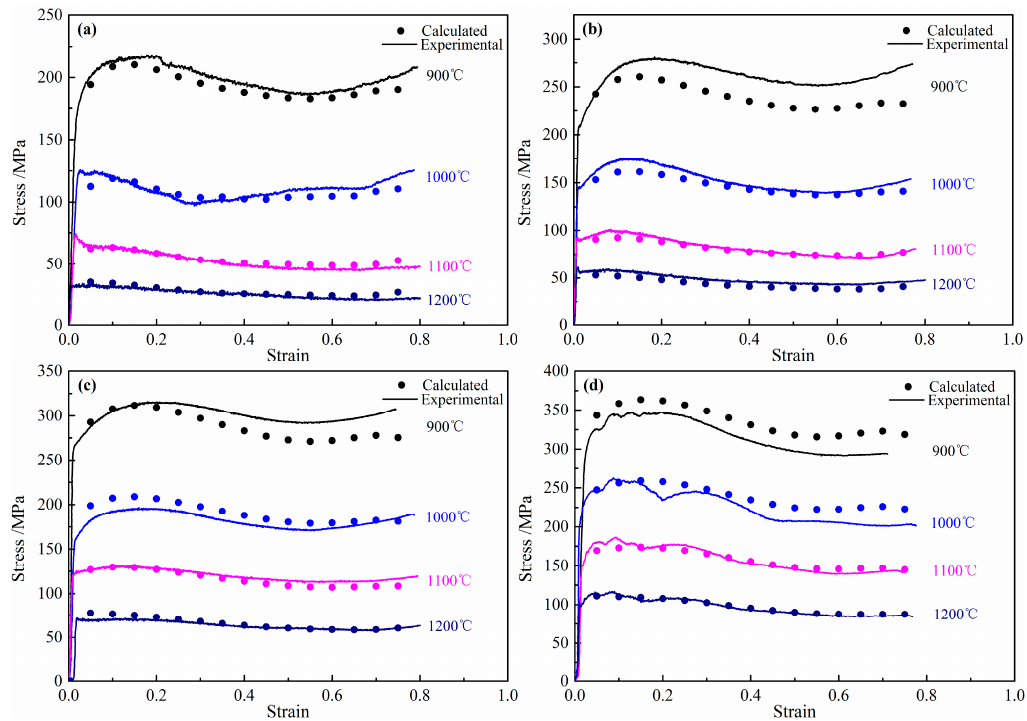
Figure 12. Comparison between calculated and experimental flow stress curves at strain rates: ( a ) 0.01 s − 1 ; ( b ) 0.1 s − 1 ; ( c ) 1 s − 1 ; ( d ) 10 s − 1 . ( a ) 0.01 s − 1 ; ( b ) 0.1 s − 1 ; ( c ) 1 s − 1 ; ( d ) 10 s − 1